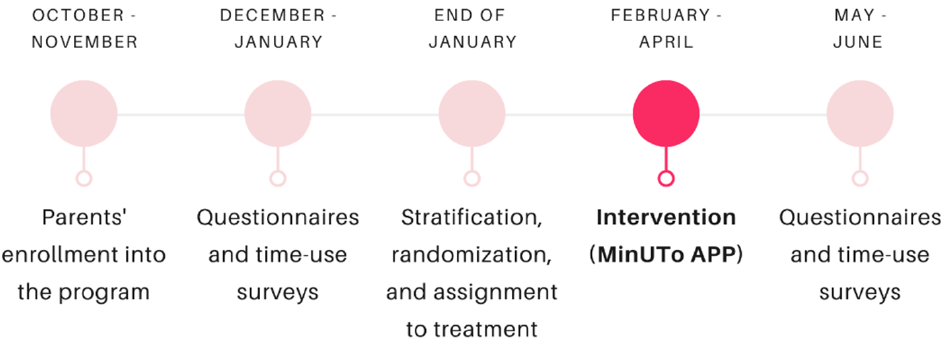
Figure 1. Timeline of MinUTo for each wave.